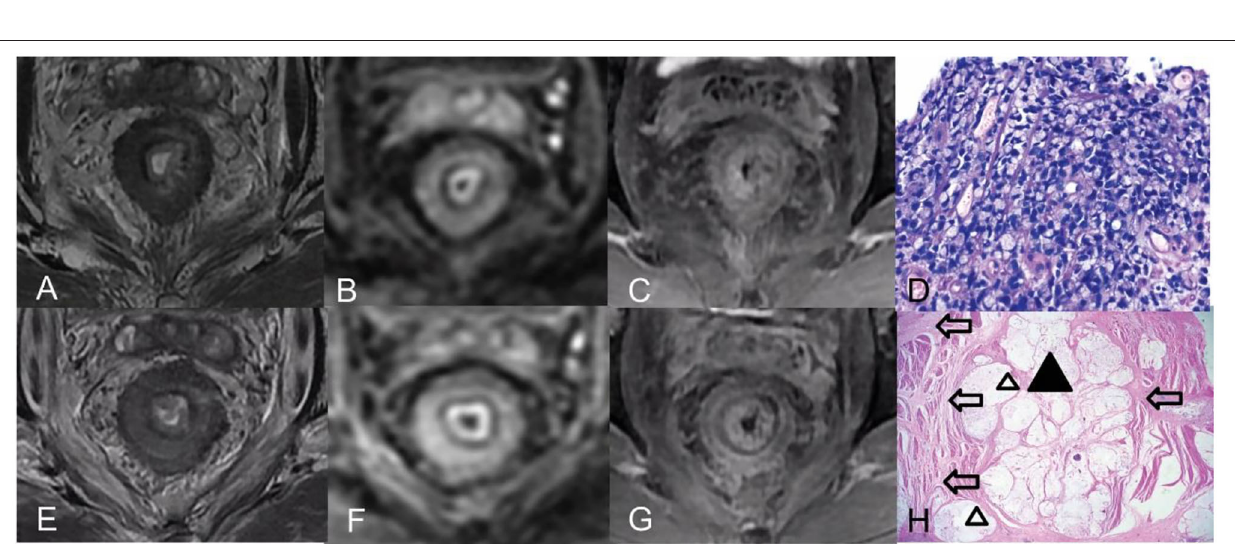
FIGURE 2 | Pre- and post-CRT rectal MR images and pathology images of a 46-year-old woman [good responder (1) with RSRCC]. (A–C) axial T2WI, DWI, and contrast-enhanced T1WI pre CRT, the rectal mural showed a target sign with high SI on T2WI (A) , a thick ring sign with slightly high SI on DWI (B) , and persistent enhancement of the entire mural layers (C) . (D) The biopsy showed 100% of SRCs (Hematoxylin and eosin staining, × 400). (E–G) Axial T2WI, DWI, and delayed contrast-enhanced T1WI post-CRT, the lesion showed similarly to that of pre CRT on T2WI (E) , which resulted in mrTRG 5 in the evaluation of CRT response. However, the thin target sign on DWI indicated complete response (F) , and the decreased enhancement of the mural also indicated a good response (G) . (H) An extensive mucin pool infiltrated the mural layers with detached muscular bands (an empty triangle) (Hematoxylin and eosin staining, × 20).